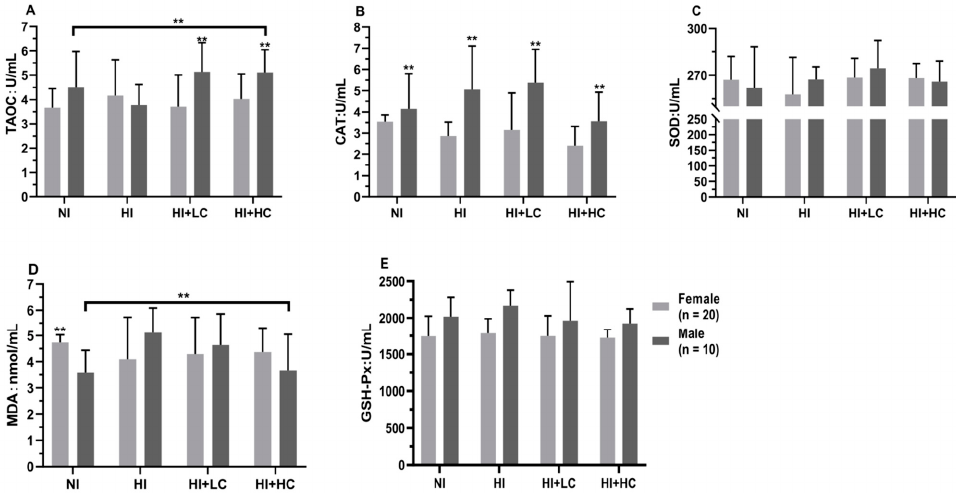
Figure 1. Protection of vitamin C from oxidative damage in serum for different sexes. ( A ) The activity of TAOC; ( B ) The activity of CAT; ( C ) The activity of SOD; ( D ) The content of MDA; ( E ) The activity of GSH-Px. All data are presented as mean and deviation. ** represents p < 0.01.